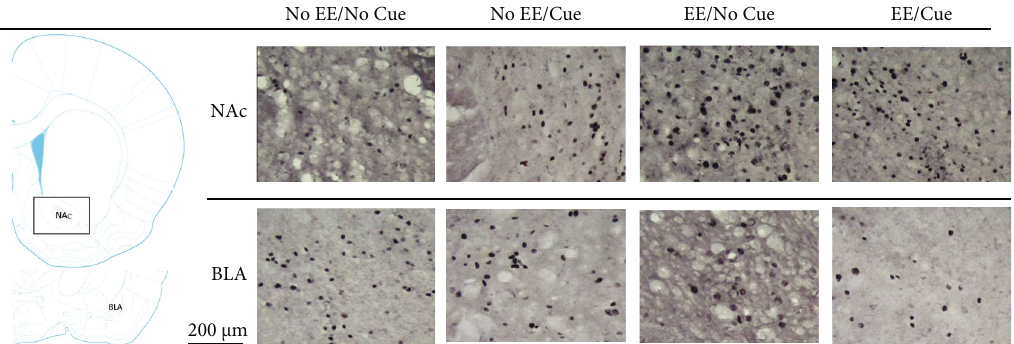
Figure 10: (a) A schematic brain atlas for the NAc and the amygdala ’ s BLA. (b) Representative photomicrographs of the c-Fos expression for the NAc and the amygdala ’ s BLA in the no EE/no cue, no EE/cue, EE/no cue, and EE/cue groups ( n = 4 , per group). Scale bar represents 200 μ